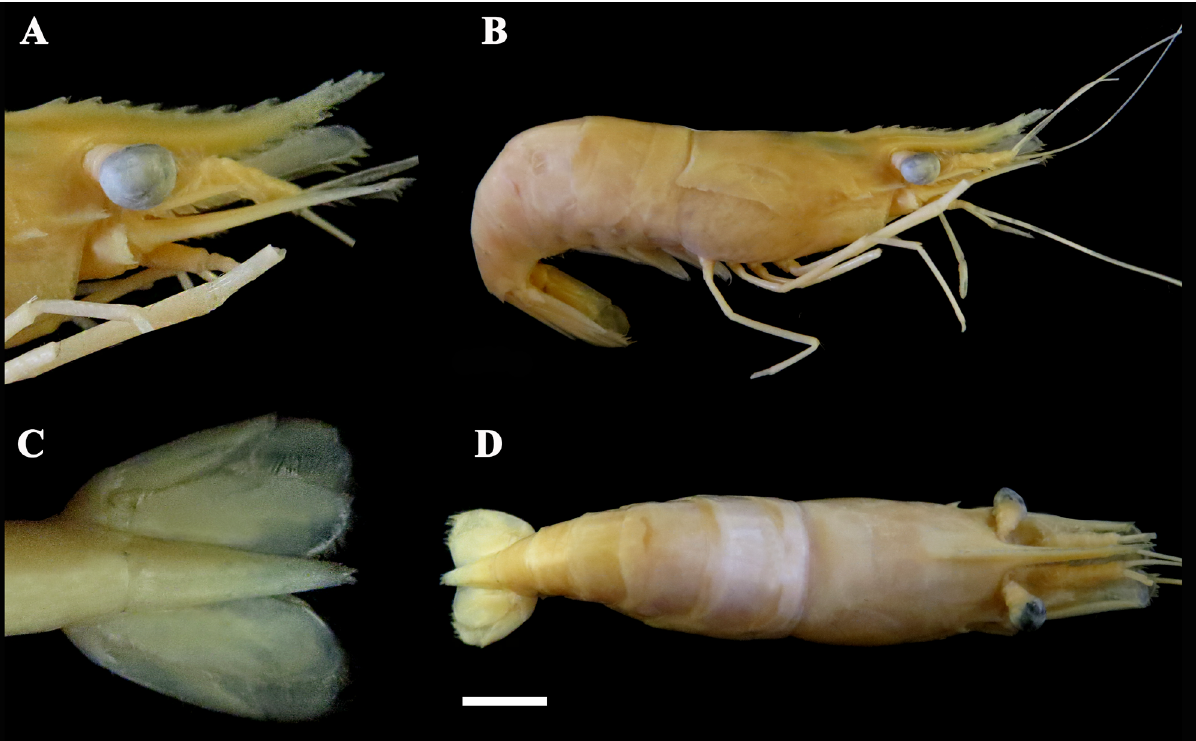
Figure 2. Macrobrachium acanthurus (Wiegmann, 1836), female (LSZ 019). A, Detail of the anterior region of the carapace; B, habitus, lateral view; C, detail of the telson and uropods, dorsal view; D, habitus, dorsal view. Scale bar: 1